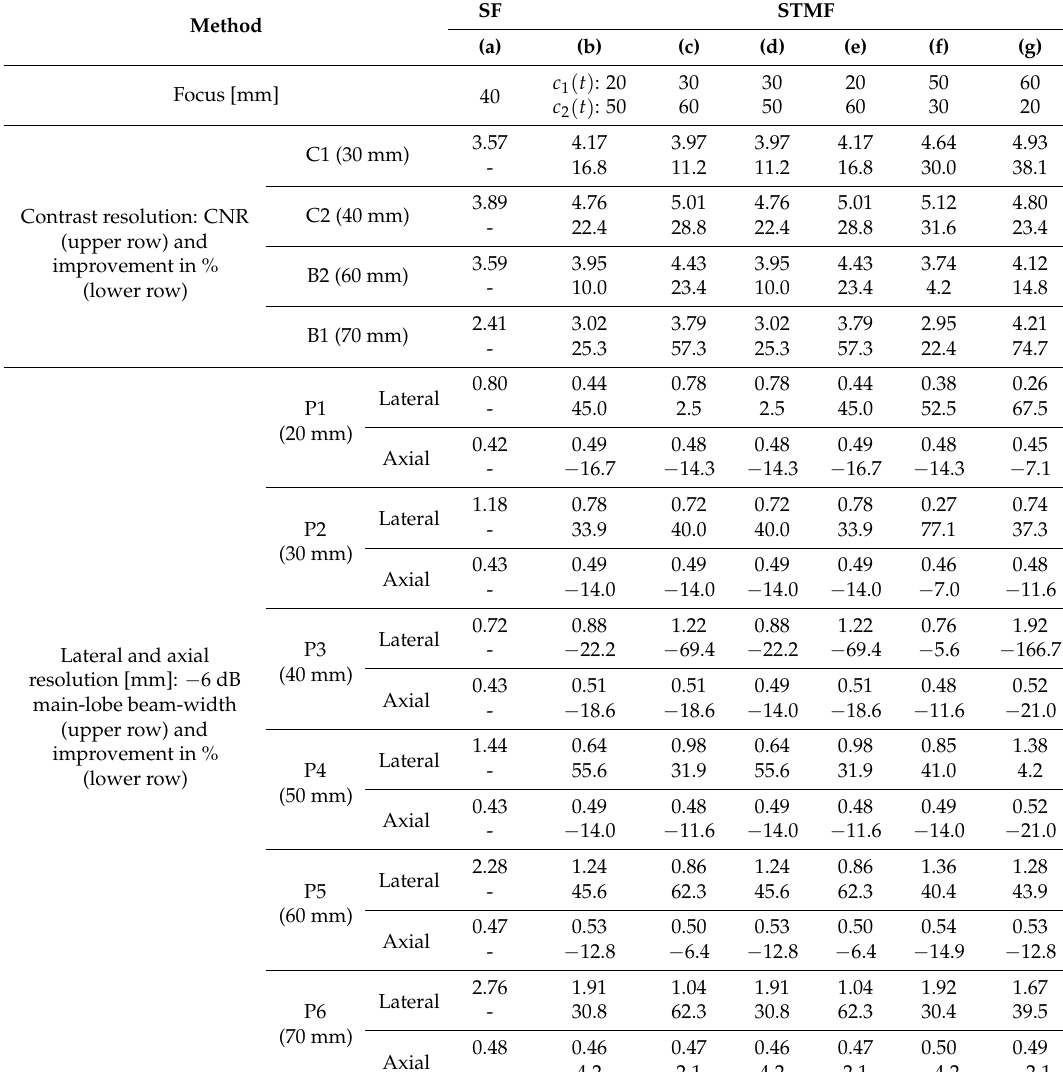
Table 2. Quantitative evaluation and improvement in % of contrast resolution (CNR) and spatial resolution ( − 6 dB beam width in lateral and axial